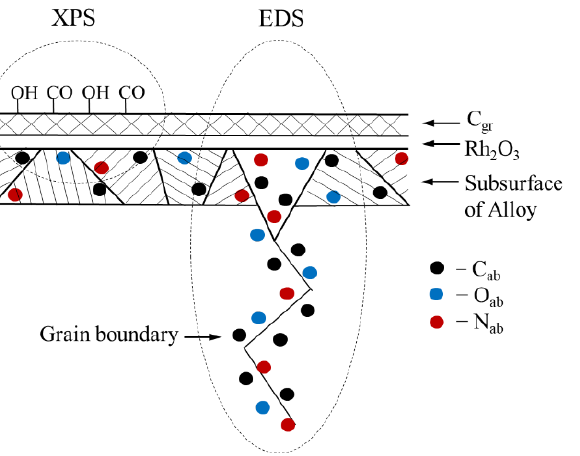
Figure 6. A scheme of the surface and subsurface regions of the Pt–Pd–Rh–Ru gauze used in the oxidation of NH 3 . OH ad , CO ad , C gr , Rh 2 O 3 —the surface adsorption, graphitic and oxide films. C ab , O ab and N ab —the atoms absorbed on grain boundaries and other defects in the subsurface layer of metallic alloy. Ellipses indicate relative depths of analysis for XPS (ca. 5 nm) and EDS (ca. 500 nm). OH and CO designate the adsorbed layer.